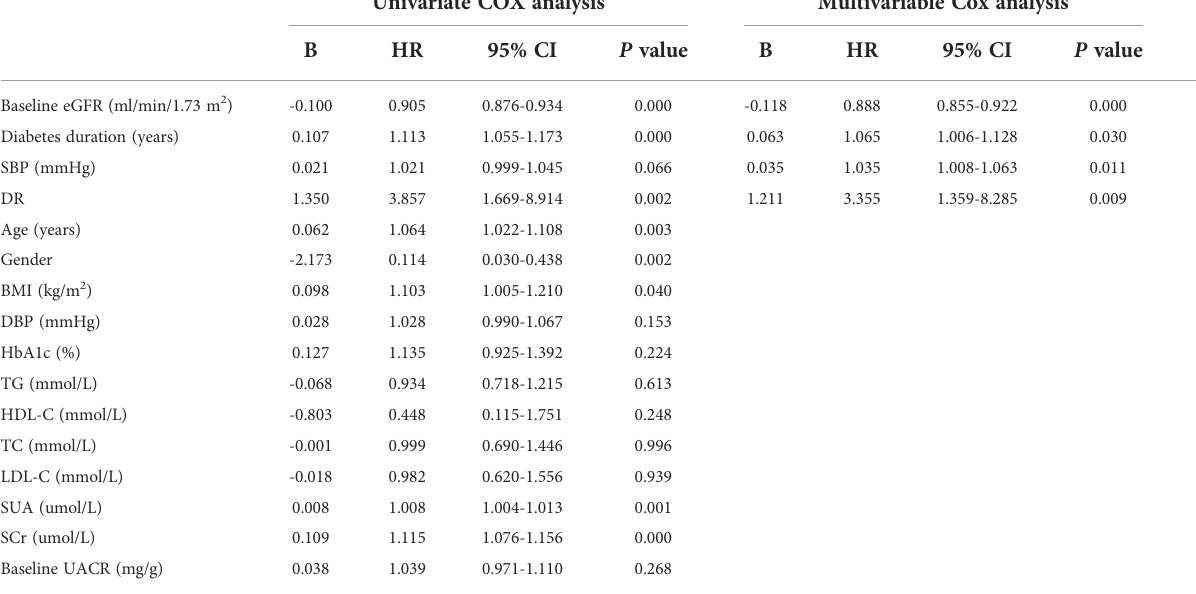
TABLE 2 Univariate and multivariable Cox analysis for the risk factors of DKD.